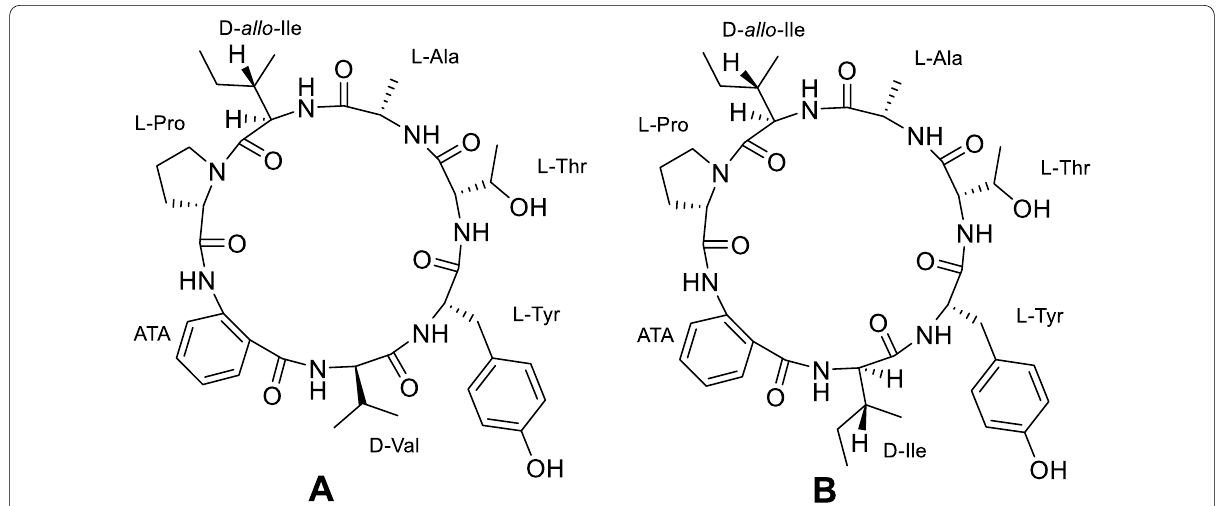
(Fig. 2 and Additional file 1: Figs. S3.1–S3.7, S3.9–S3.11), as well as a detailed analysis of the MS/MS